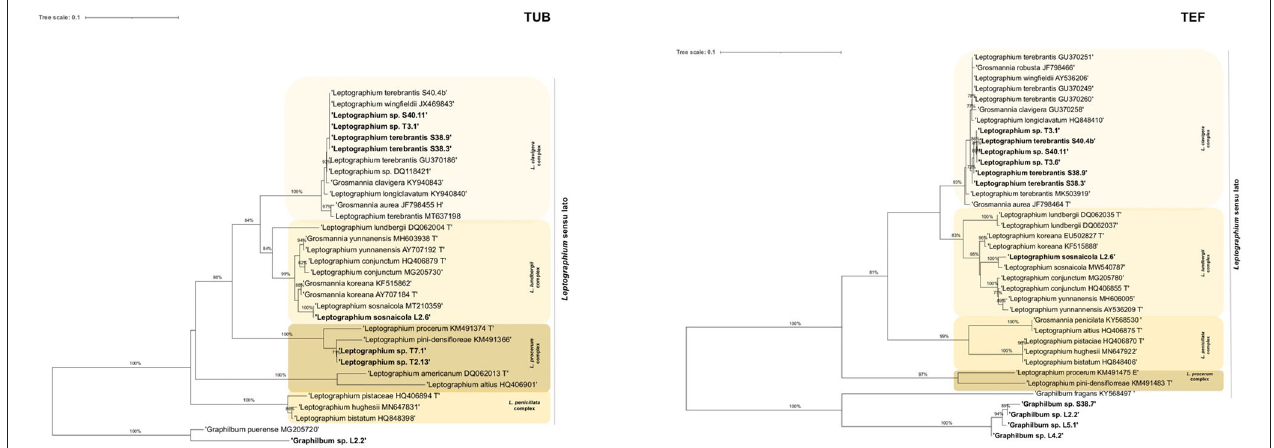
FIGURE 2 | Maximum likelihood trees of Leptographium sensu lato generated by β -tubulin (TUB) and elongation factor 1- α (TEF) DNA sequence data. Sequences generated from this study are presented in bold ( Table 2 ). Bootstrap values ≥ 70% are presented above the respective branch. Branch length is a measure of the number of substitutions per site (scale bar). T = ex-type isolates.